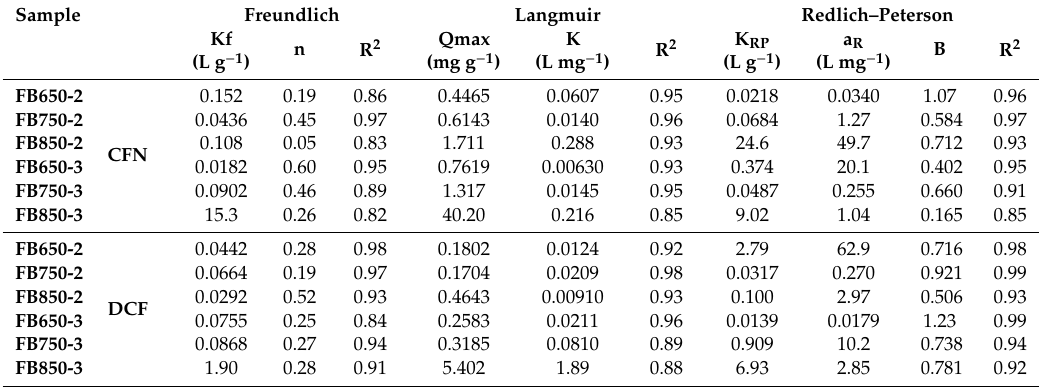
Table 3. Parameters of the Langmuir, Freundlich and Redlich–Peterson isotherm models for ca ff eine and diclofenac adsorption onto fique bagasse biochar at 20 ◦ C.